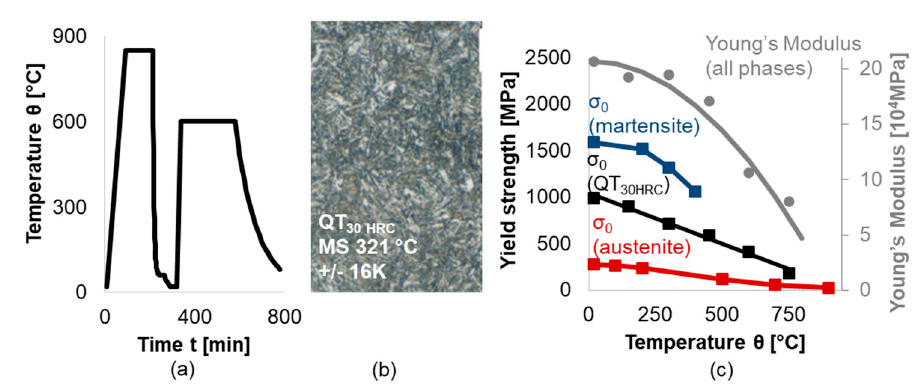
Figure 3. ( a ) Heat treatment for generating the quenched and tempered initial microstructure with a hardness of 30 HRC ( b ), and the temperature and phase dependent yield strength σ 0 and phase independent Young’s modulus ( c ).